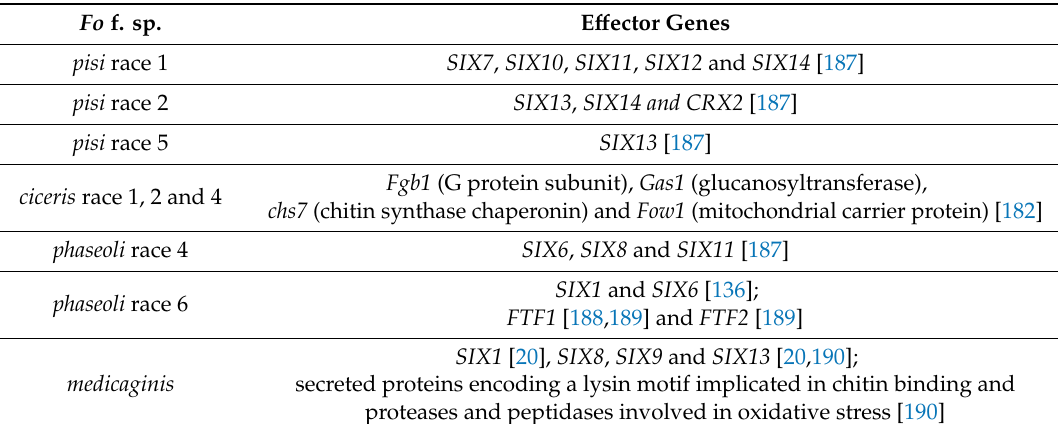
Table 5. Known e ff ector genes among Fo ff . spp. and races infecting legumes. Fo f.